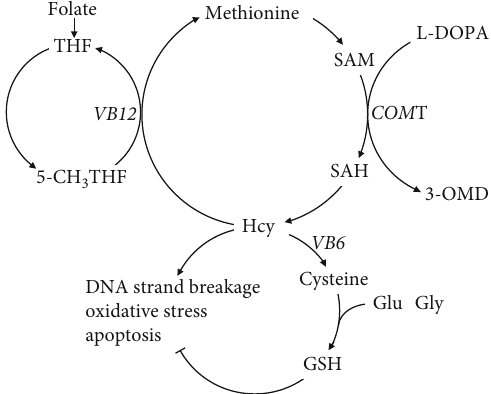
Figure 1: The role of homocysteine in the methionine cycle. In the presence of folate and vitamin B12, homocysteine (Hcy) is converted to methionine. Methionine is converted back to Hcy through a series of reactions under the catalysis of catechol-O- methyltransferase, and this catalytic reaction can reduce levodopa. On the one hand, Hcy can cause synaptic dysfunction and cell death through DNA strand breakage, oxidative stress, and apoptosis. On the other hand, Hcy can be converted to cysteine, which is the raw material of glutathione. Glutathione can reduce the adverse e ff ects of Hcy to a certain extent. 3-OMD: